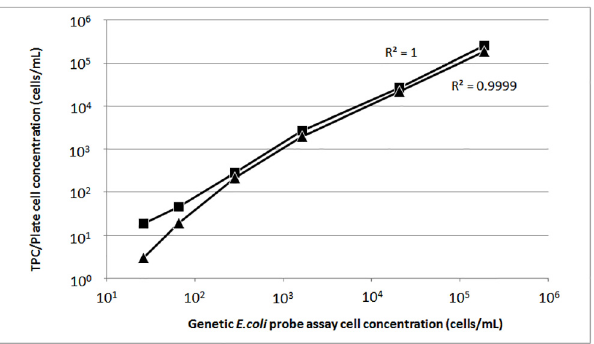
Fig 6. Challenge test of generic E . coli probe assay. E . coli O157 culture was diluted over 6 orders of magnitude, mixed with equal volume of Salmonella enterica overnight culture, and assessed by generic E . coli probe assay, TPC assay and agar plate counting. The sensitivity of the R-squared value between genetic probe assay and TPC assay ( & ) is 1, and the R-squared value between genetic probe assay and agar plate counting ( ▲ ) is 0.9999. Each data point is an average of 3